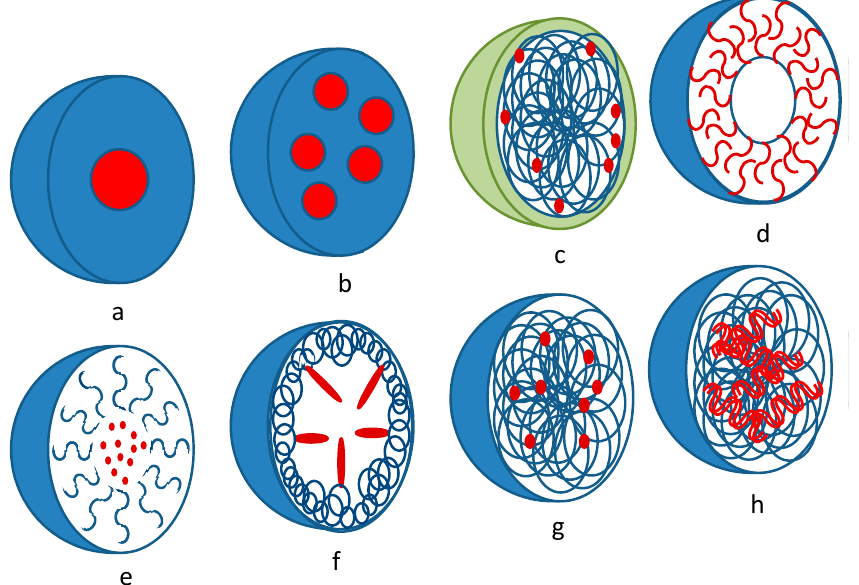
Figure 2. Schematic representation of different types of micro- or nanoparticles: ( a ) core-shell particle; ( b ) multidomain particle; ( c ) layer-by-layer coated particle with encapsulated drug; ( d ) liposome or polymerosome; ( e ) micelle; ( f ) self-assembled particle with conjugated drug; ( g ) micro/nanogel; ( h ) polyplex.